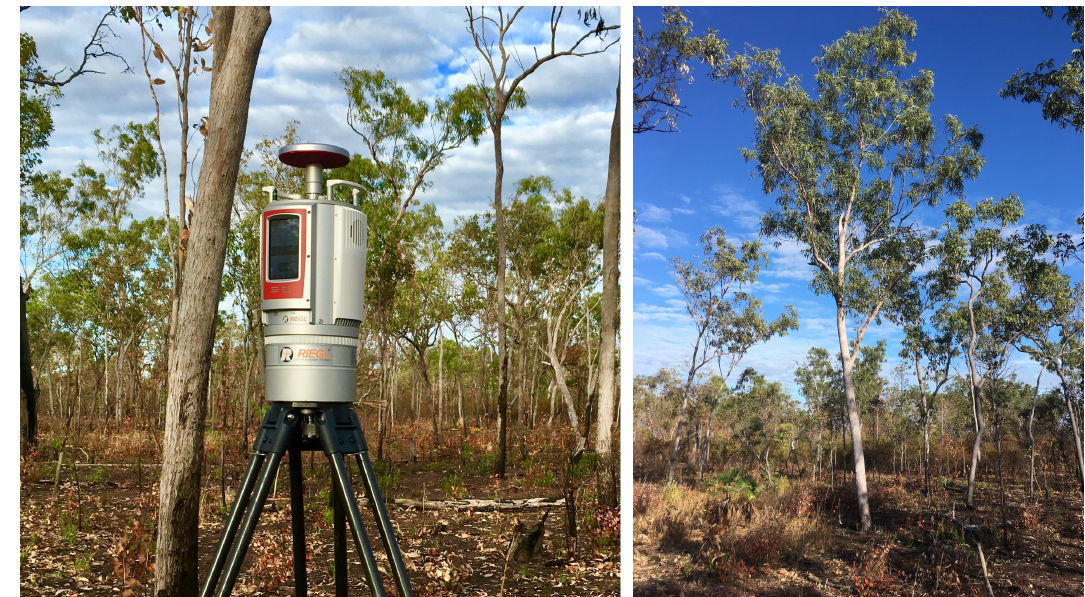
Figure 2. Site conditions at the time of the LiDAR surveys. Occlusion from the grass layer was minimal due to the effects of a fire one month prior.